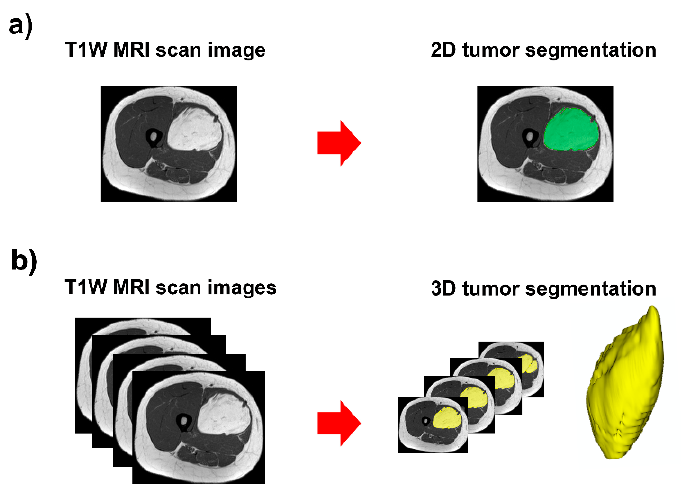
Figure 1. Contour-focused segmentation provides the region of interest of the tumor: ( a ) 2D tumor segmentation in green area; and ( b ) 3D tumor segmentation in yellow area.